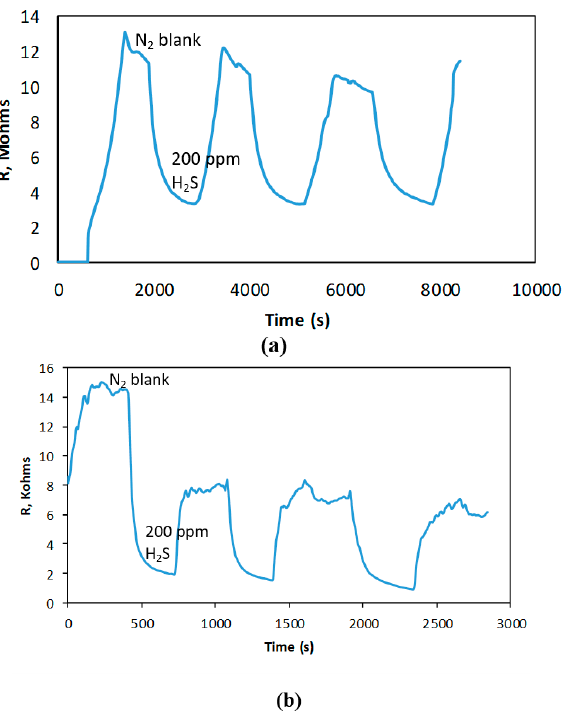
Figure 9. A comparison of the reversibility of the response of ( a ) PI / AuNPs, and ( b ) PANI / AuNPs-based chemiresistor sensors towards 200 ppm H 2 S at RT (cycles = 3).